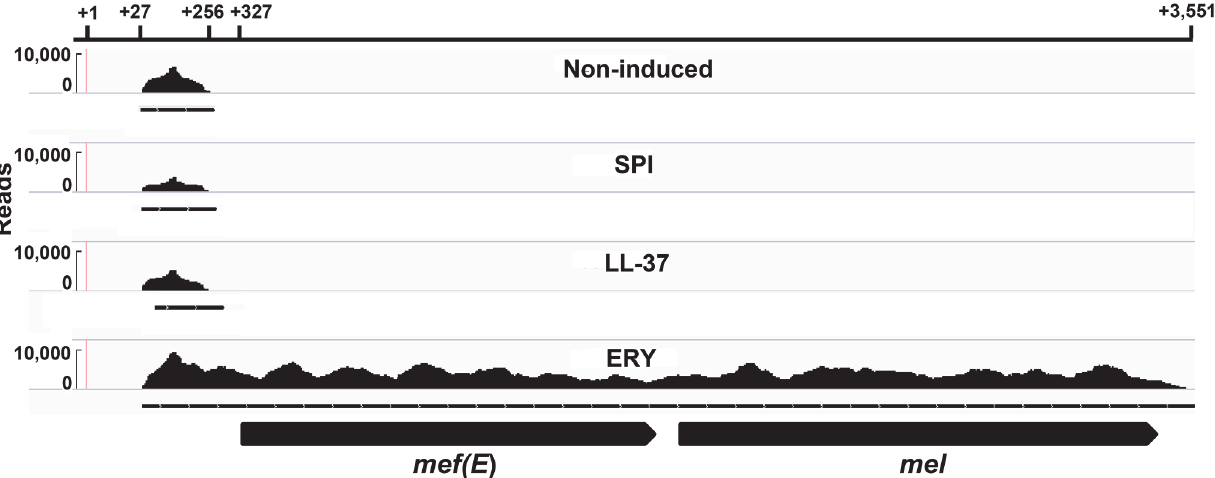
Fig 7. Visualization of mef(E) attenuator by RNA-Seq. Whole transcriptome analysis by RNA-Seq of mRNA from the wild type strain GA17457, non- induced or exposed to spiramycin, the antimicrobial peptide, LL-37, or erythromycin. The number of sequence reads correlated to the mef(E)/mel transcript is shown on the graph. Dashed lines below each sample indicate transcripts predicted by Integrated Genome Viewer (IGV). The mef(E) and mel open reading frames are shown